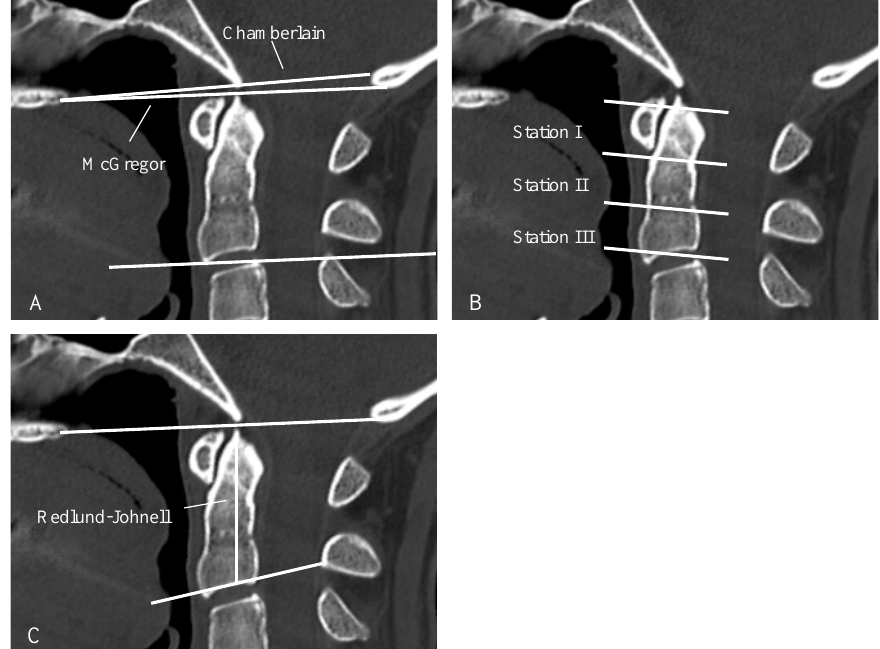
Figure 1. Ranawat criteria: Line from the center of the anterior C1 arch to the center of the posterior C1 arch. A second line goes through the axis from the odontoid to the center of the base of the C2. The smaller the distance (R) to the crossing of the lines, the more pronounced the invagination. A distance > 13 mm for women and > 15 mm for men is normal [8].